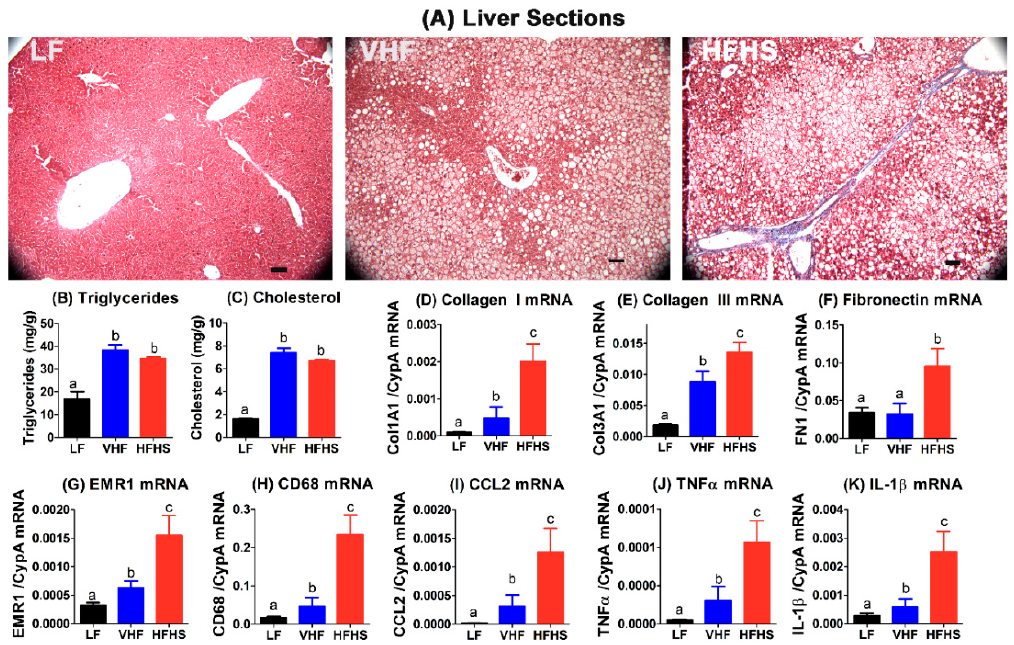
Figure 5. High-fat diet with excess sucrose accelerates hepatosteatosis transition to steatohepatitis. Livers were collected from C57BL / 6J mice fed low fat (LF), very high fat (VHF), or moderately high fat with excess sucrose (HFHS) diets for 12 weeks. Representative liver tissue section images are shown in ( A ). Scale bar = 50 µ m. Liver triglyceride ( B ) and cholesterol content ( C ) were determined from 6 mice in each group. Bars in groups with letters a and b are significantly di ff erent at p < 0.05 (1-way ANOVA with Bonnferroni post hoc analysis). RNA was extracted from the livers of 5 LF-fed mice, 7 VHF-fed mice, and 9 HFHS-fed mice to measure expression levels of collagen-I ( D ), collagen-III ( E ), fibronectin ( F ), EMRI (F4 / 80) ( G ), CD68 ( H ), CCL2 / MCP1 ( I ), TNF α ( J ), and IL-1 β ( K ). In the gene expression data, bars with di ff erent letters indicate statistically significant di ff erence between groups at p < 0.05 (1-way ANOVA with Bonferroni post hoc analysis).